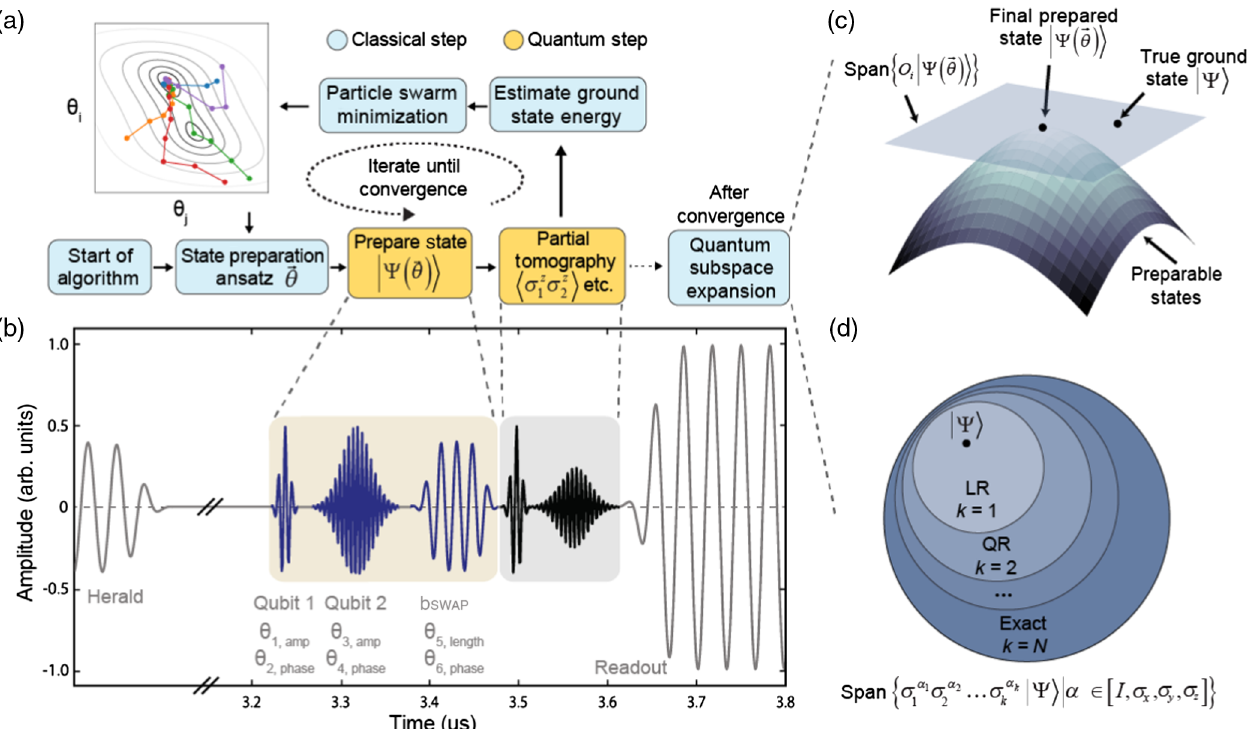
FIG. 1. Description of the variational quantum eigensolver algorithm and associated quantum subspace expansion. (a) Mapping between qubit states and electronic states of the hydrogen molecule in the STO-3G basis. As the molecular Hamiltonian preserves total 0 (dashed box) decouple from the other two. These four are mapped to the four two-qubit basis spin projection, the four states with s z ¼ states. (b) Flow chart outline of the algorithm with classical resources colored in blue and quantum resources colored in yellow. Inset shows a cartoon example of the swarm minimization process with equal-energy contours shown in gray scale and 5 swarm particle trajectories (colored). (c) Cartoon of the QSE protocol; operators from O are used to expand about the variational solution provided by i the VQE, allowing for the mitigation of incoherent errors that otherwise render the true ground state inaccessible. (d) Typical qubit preparation and measurement sequence consisting of a projective heralding measurement (on which we later postselect so that the qubits start in the state j 00 i ), single-qubit and two-qubit pulses, tomography pulses, and finally a projective